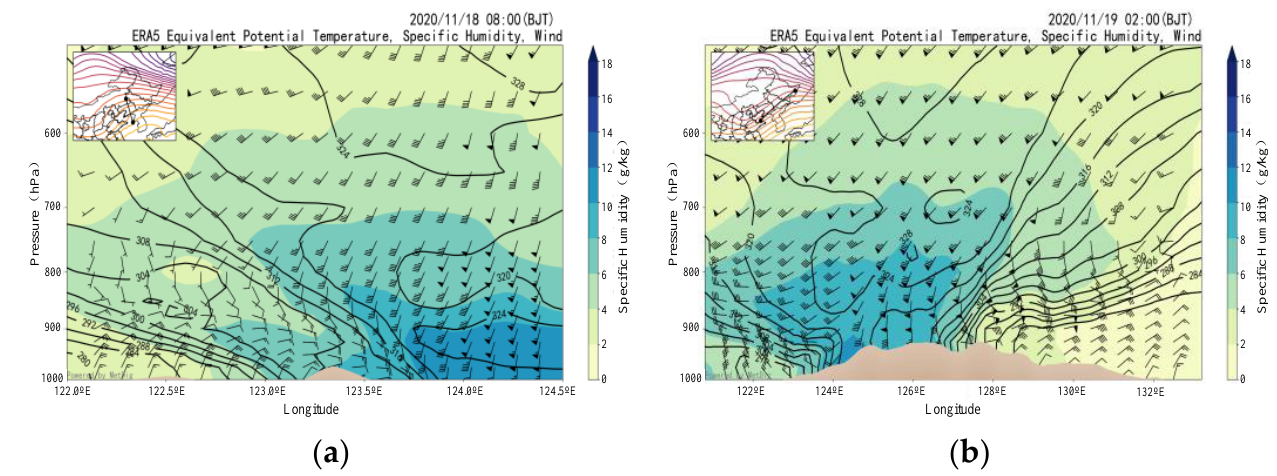
Figure 9. ( a ) the altitude and longitude profile of equivalent potential temperature (line), absolute humidity (coloring) and profile wind at 08:00 on 18 November, ( b ) the altitude and longitude profile of equivalent potential temperature (line), absolute humidity (coloring) and profile wind (wind) at 02:00 on 19